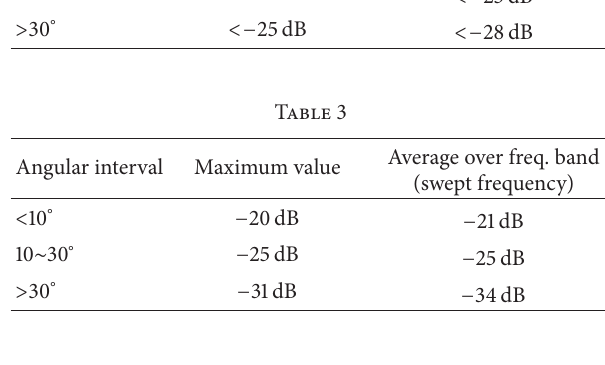
Angular interval Maximum value Average over freq. band